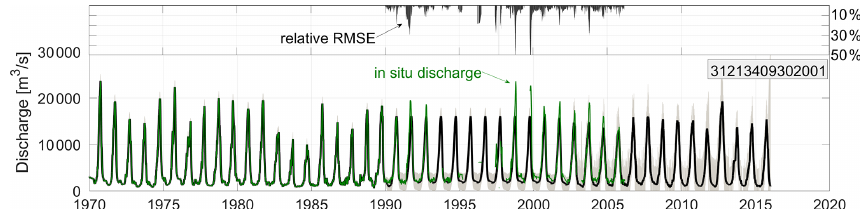
Figure 8. Daily river discharge over the Niger River at Lokoja by assimilating altimetric discharge with available in situ